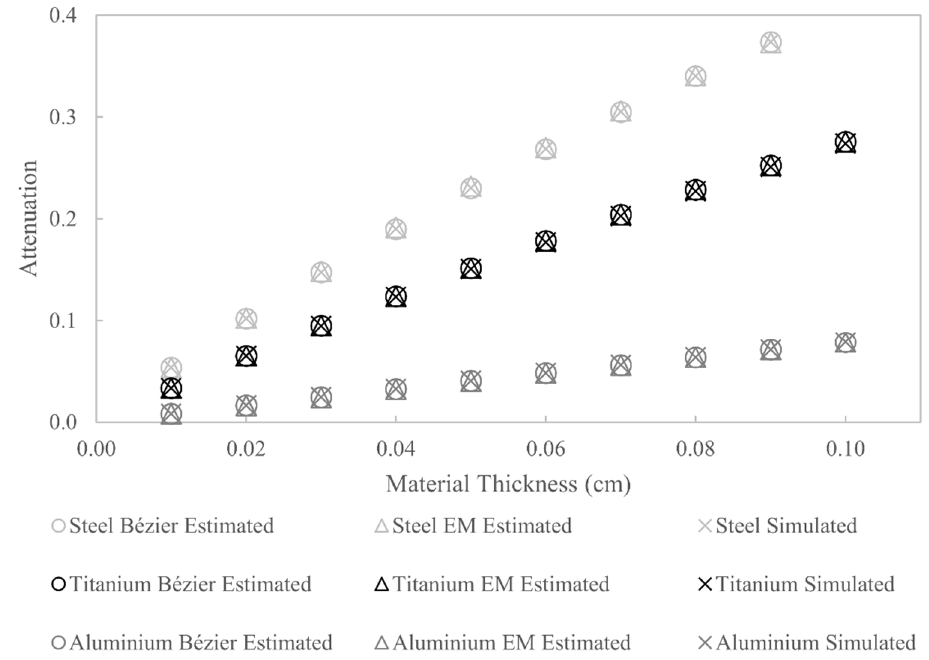
Figure 10. Comparison between simulated and estimated X-ray attenuation for aluminium, titanium and steel.